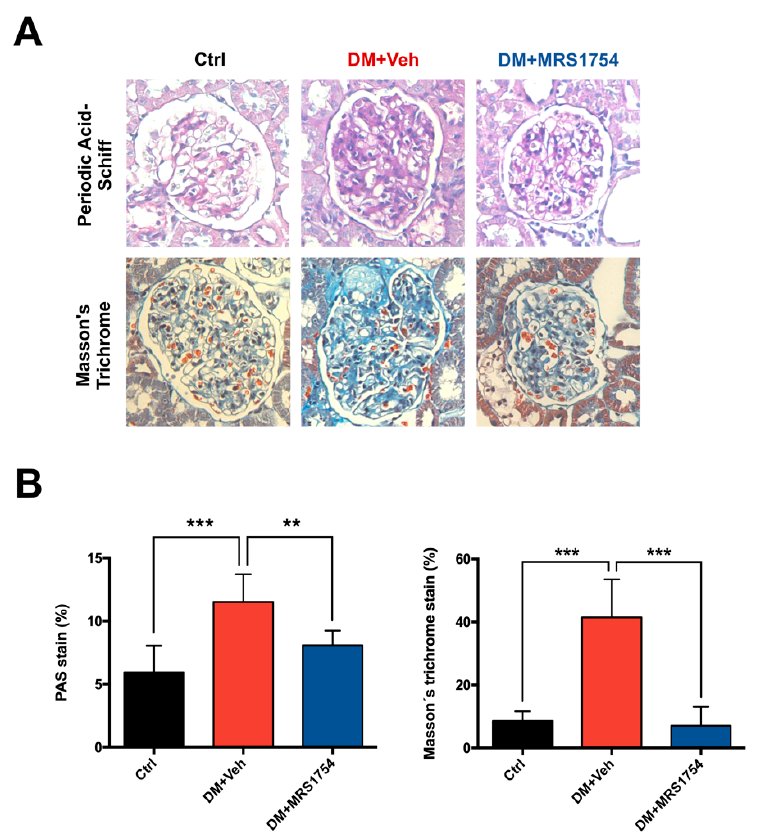
Figure 2. In vivo MRS1754 treatment decreases glomerular fibrosis in diabetic rats. ( A ) Periodic acid–Schiff (PAS) and Masson’s trichrome (MT) stains with its ( B ) quantification in kidneys of non-diabetic (black; Ctrl), diabetic vehicle-treated (red; DM + Veh) and diabetic MRS1754-treated (blue; DM + MRS1754) rats at week twelve post-STZ inoculation. Diabetic rats were treated with MRS1754 (0.5mg / kg / 48 h i.p.) for eight weeks, four weeks after STZ inoculation. Graphs represent the percentage (mean ± S.D) of PAS or MT stained area in the glomeruli. ** p < 0.01, *** p < 0.005 between groups. n = 6. Magnification 400x.